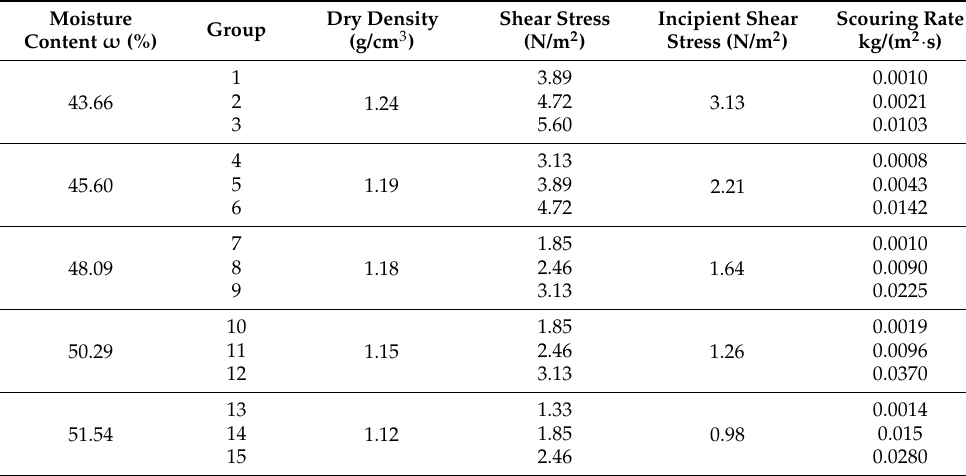
Table 3. Test results of the scouring rate of cohesive soil sample